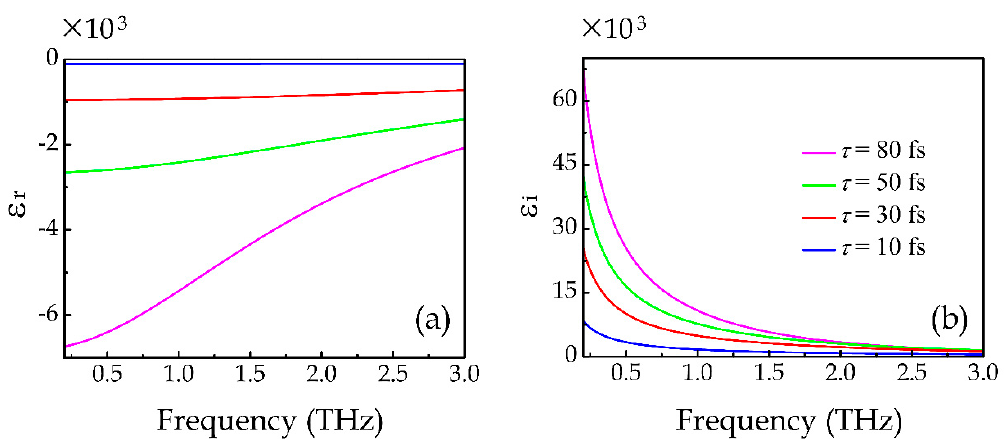
Figure 4. Calculated ( a ) real parts and ( b ) imaginary parts of graphene permittivity.